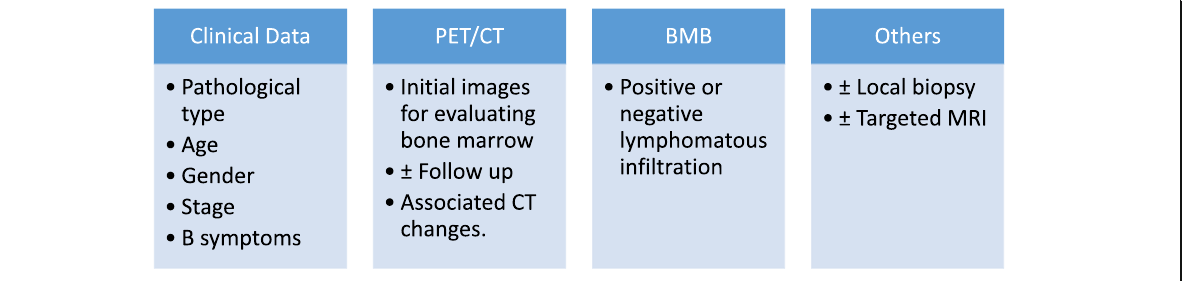
Fig. 1 The different data used in the research